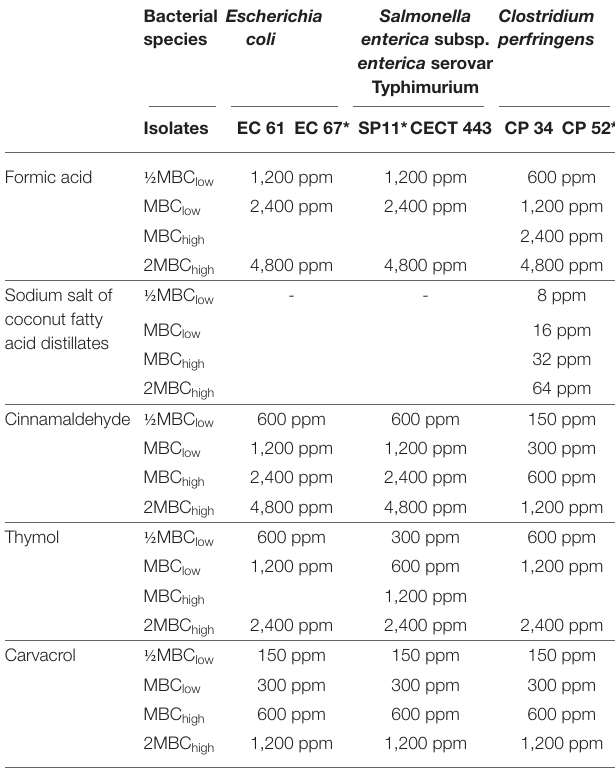
TABLE 1 | Bacterial isolates used in the study and concentration range in part per million (ppm) evaluated for each tested compound. Escherichia Salmonella Bacterial coli enterica species